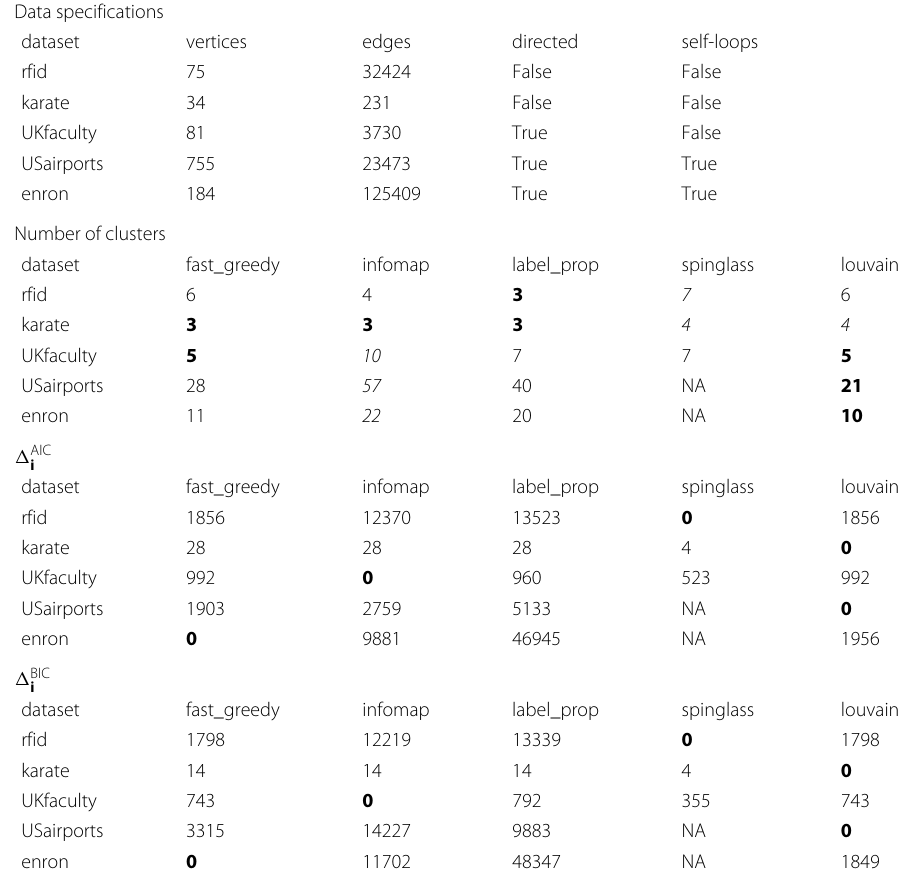
Table 5 Results of the fitting of BCCM to five real-world graphs, with vertex blocks given obtained from five different community detection